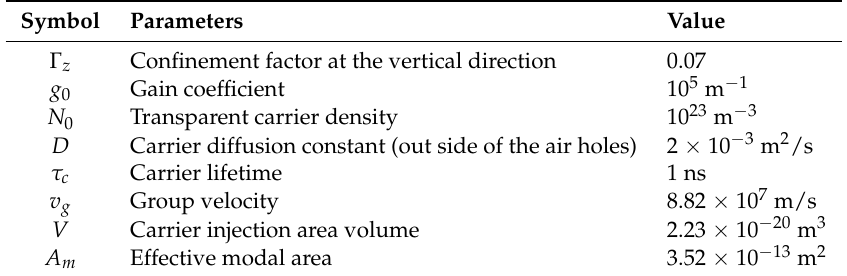
Table 2. Values of parameters for rate equation